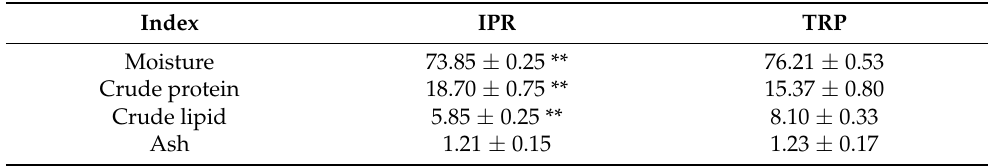
Table 5. The approximate composition of fish muscle in IPR and TRP (% wet